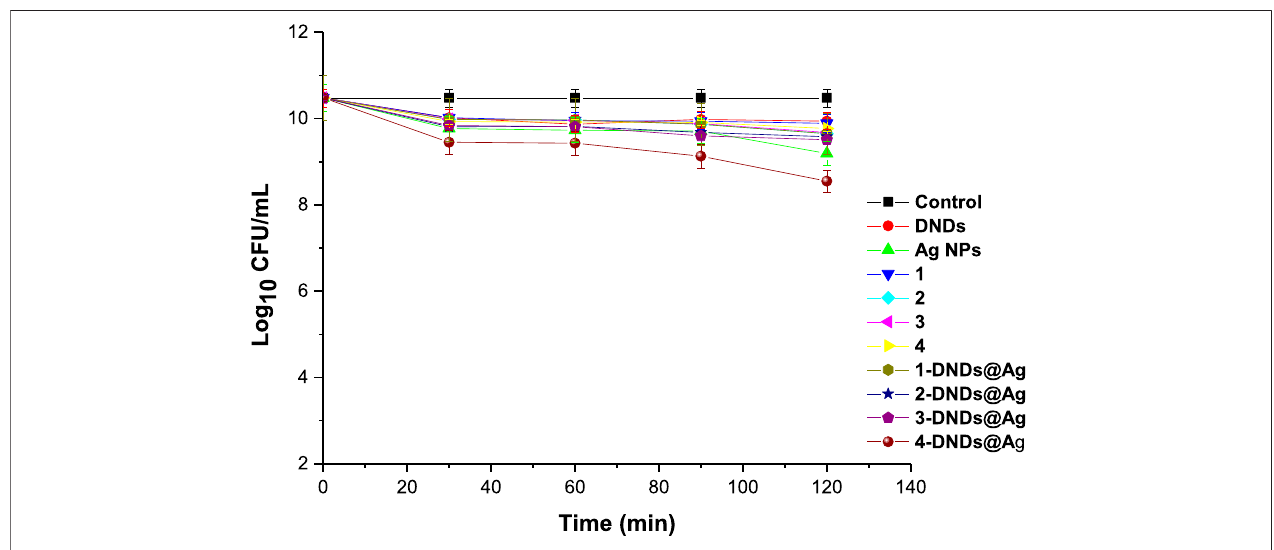
FIGURE 9 | Dark studies of the synthesized compounds on S. aureus planktonic cells (irradiation at 415 nm). Concentration (cid:2) 10 μ g/mL. Data represent the mean ± SD (standard deviation).